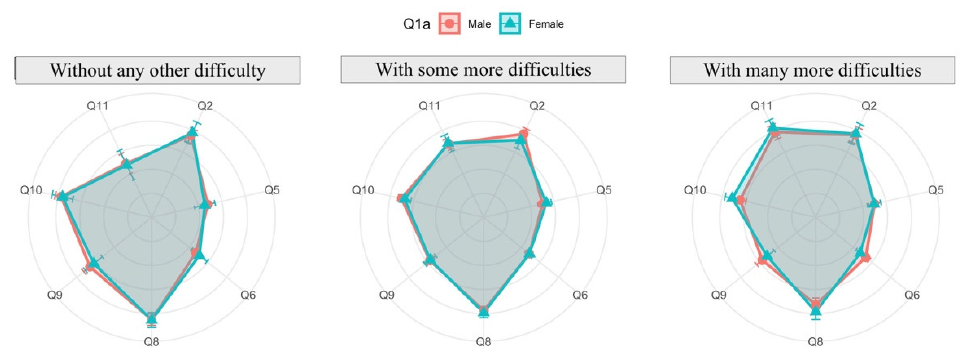
Figure 18. Reconciliation of virtual teaching activity with personal life compared to reconciliation in standard conditions (answers to Q3) related to other aspects and disaggregated by